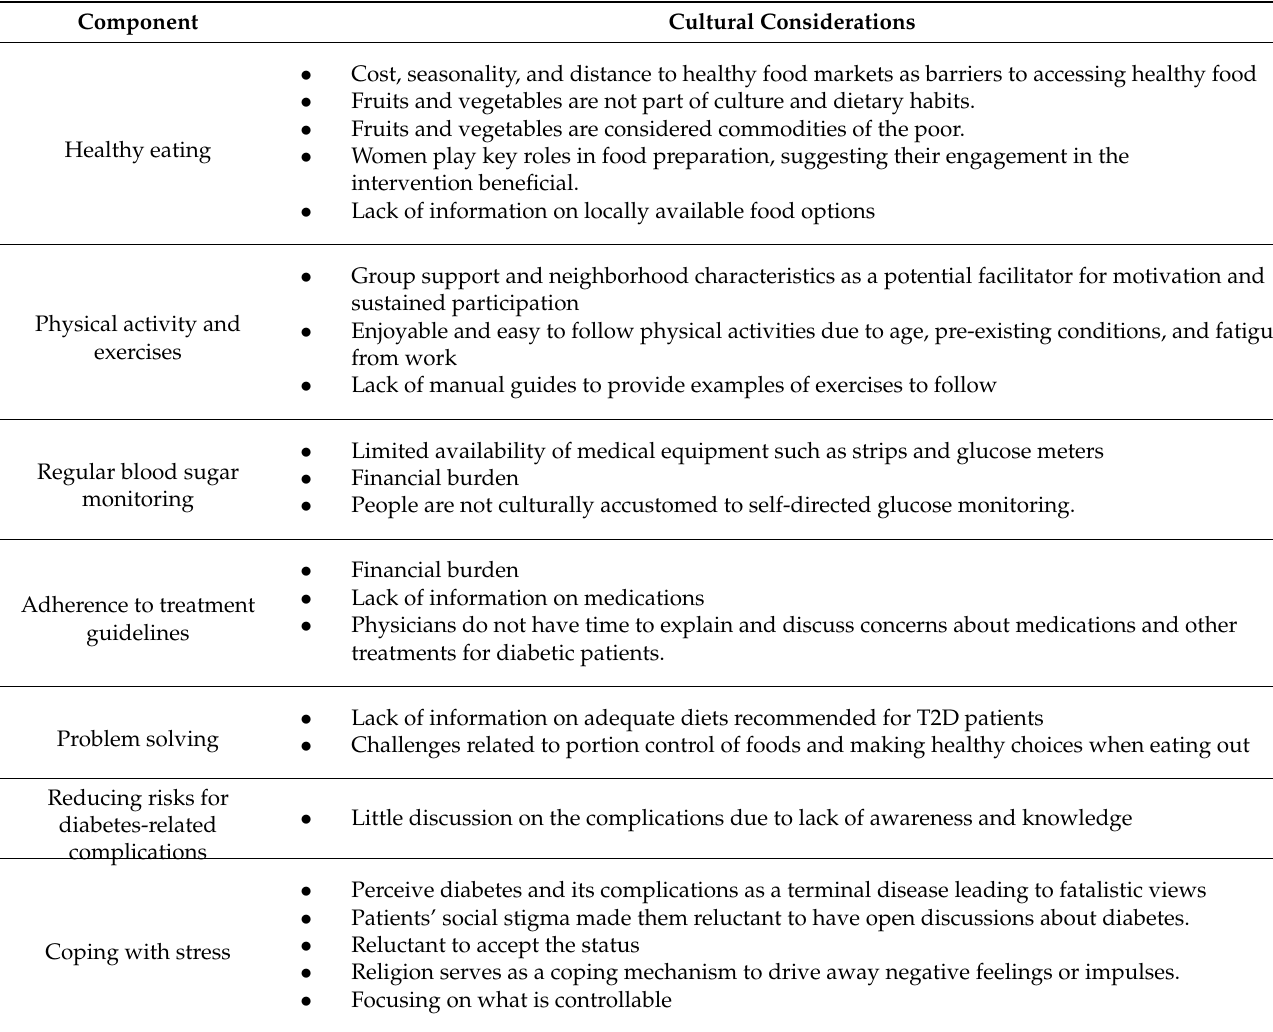
Table 2. Summary of themes and issues emerging from the